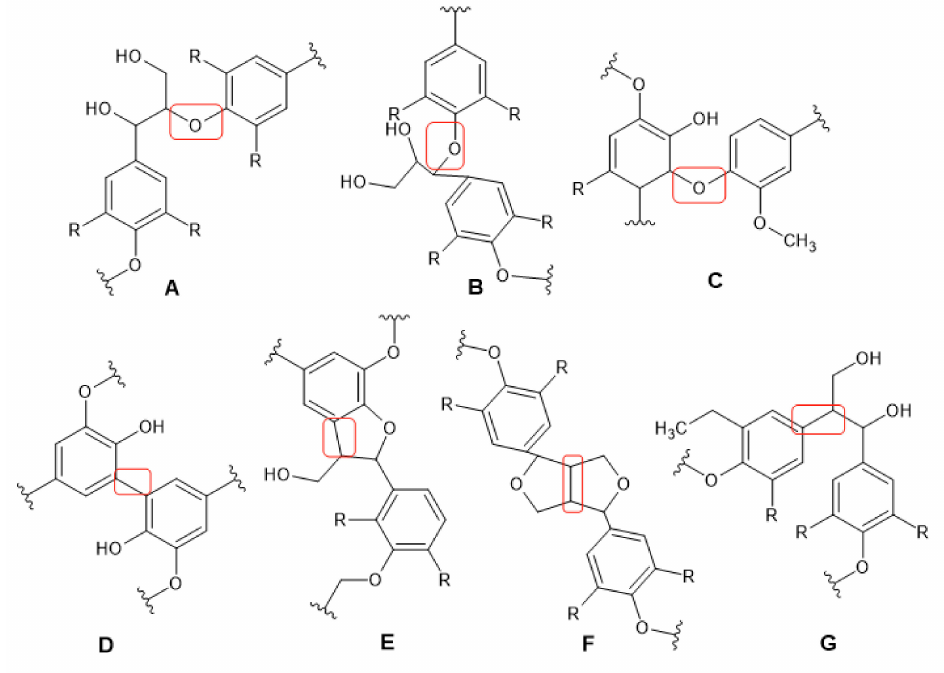
Figure 2. Chemical bonds found in lignin, comprised of both ether and carbon–carbon bonds (highlighted in red). ( A ) β -O-4, ( B ) α -O-4, ( C ) 4-O-5, ( D ) 5-5, ( E ) β -5, ( F ) β - β , ( G ) β